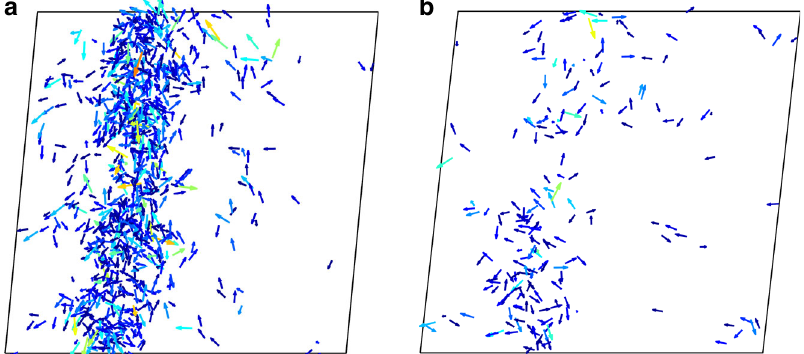
Fig. 8 Localization of microplastic activity. Displacement maps comparing the atomic displacements caused by a 0.01 increment in strain at a strain rate of 10 7 s − 1 . a , b Fast and slow dynamics, respectively. The corresponding strain regions are highlighted in the stress – strain graphs in this fi gure. Similar results are found for a strain rate of 10 5 s − 1 , which are displayed in the